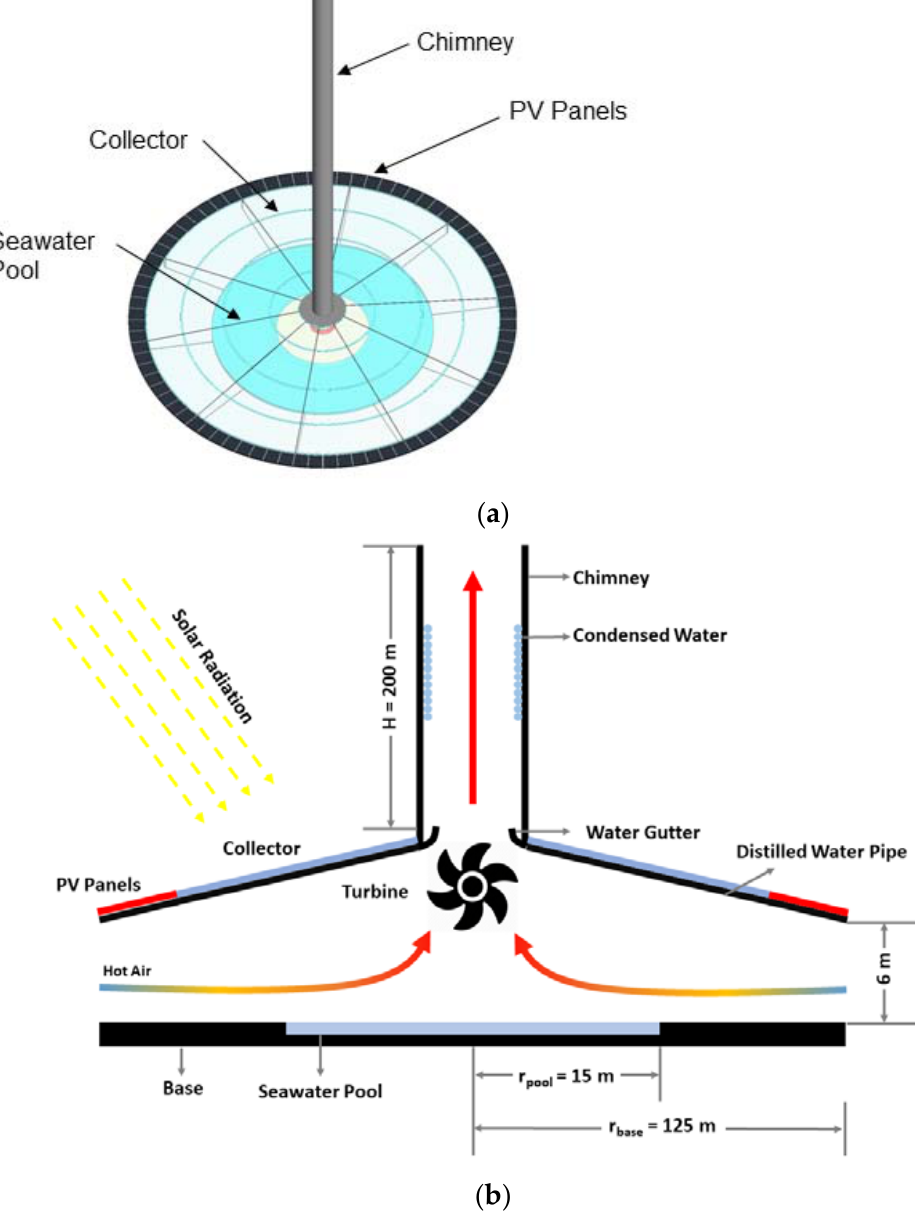
Figure 1. Illustration of the proposed SCPP integrated with PV (dark circumference): ( a ) 3D view, and ( b ) cross-section view.